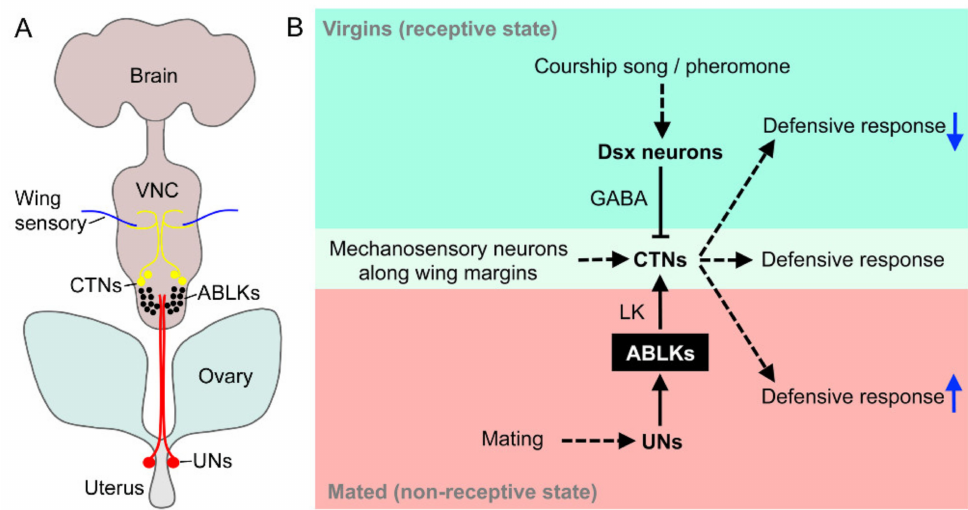
Figure 9. The role of LK signaling and ABLKs in a post-mating defensive response. ( A ) Pathway that regulates a defensive wing retraction response in female flies [118]. Mechanosensory cells in the wing margin send axons to the mesothoracic neuromere of the ventral nerve cord (VNC). They synapse on interneurons (CTNs) that modulate motoneurons, which retract the wings (not shown). A set of sensory cells (UNs) in the uterus synapse with the ABLKs. After mating, these UNs are stimulated by contents (not sex peptide) in the semen and activate the ABLKs. The ABLKs in turn activate the CTNs, and the defensive response is strengthened. ( B ) Diagram of the circuit regulating the defensive response. Virgin female flies do not display this wing defense response. This is ensured by a pathway where sensory inputs (courtship song and pheromones) to female-specific neurons that express the gene doublesex (Dsx) use GABA ( γ -aminobutyric acid) to inhibit the CTNs. In mated flies, the UNs in the uterus activate ABLKs and the CTNs enhance the defensive response. Figure 9A was drawn based on data in [118] and Figure 9B was redrawn from a figure in